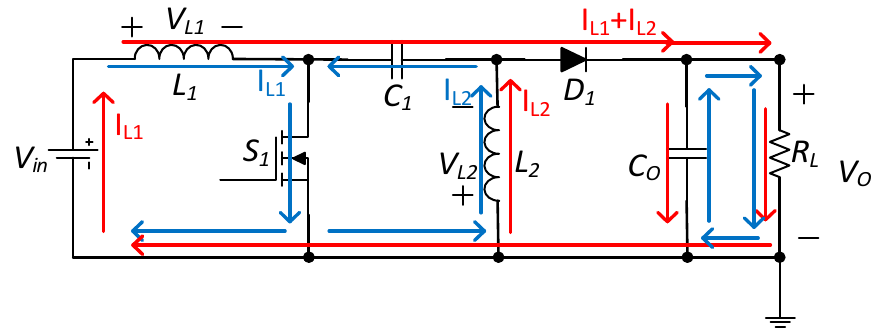
Figure 5. Operation in continuous conduction mode (CCM).